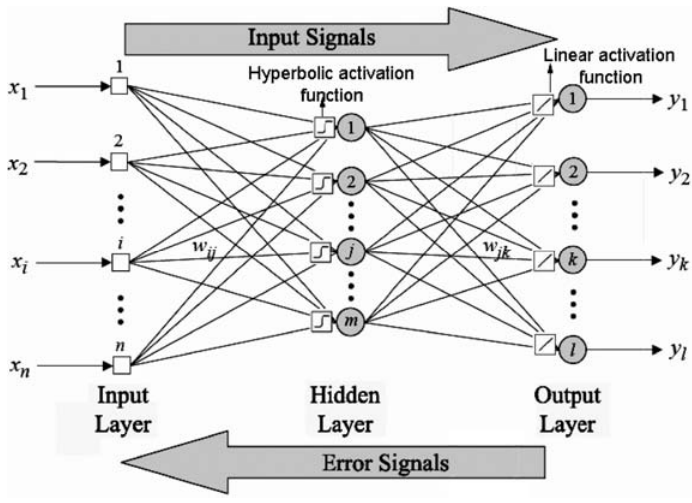
Fig. 7. Feed-forward back propagation network with one hidden